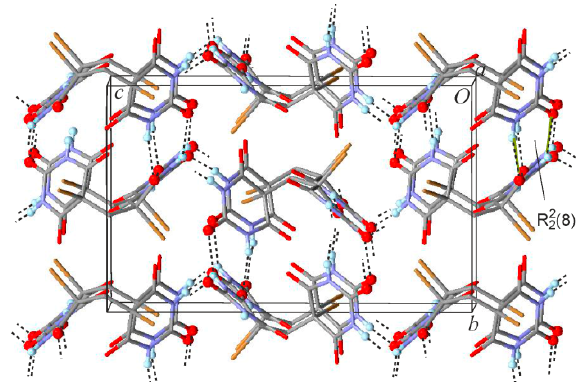
Figure 5. N–H ∙∙∙ O=C-bonded framework of 2 . O and H atoms involved in hydrogen bonding are drawn as spheres and hydrogen bonds are drawn as dashed lines.